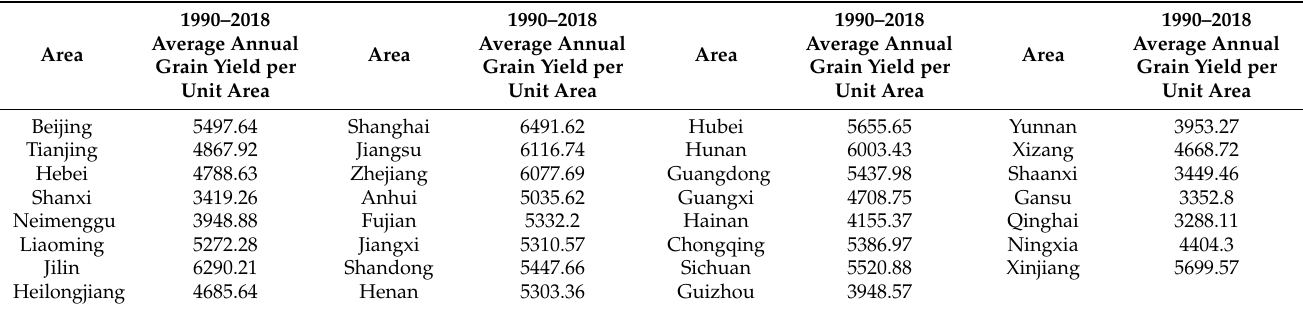
Table 1. Average grain yield per unit area by region from 1990 to 2018 (kg/hm 2 ).